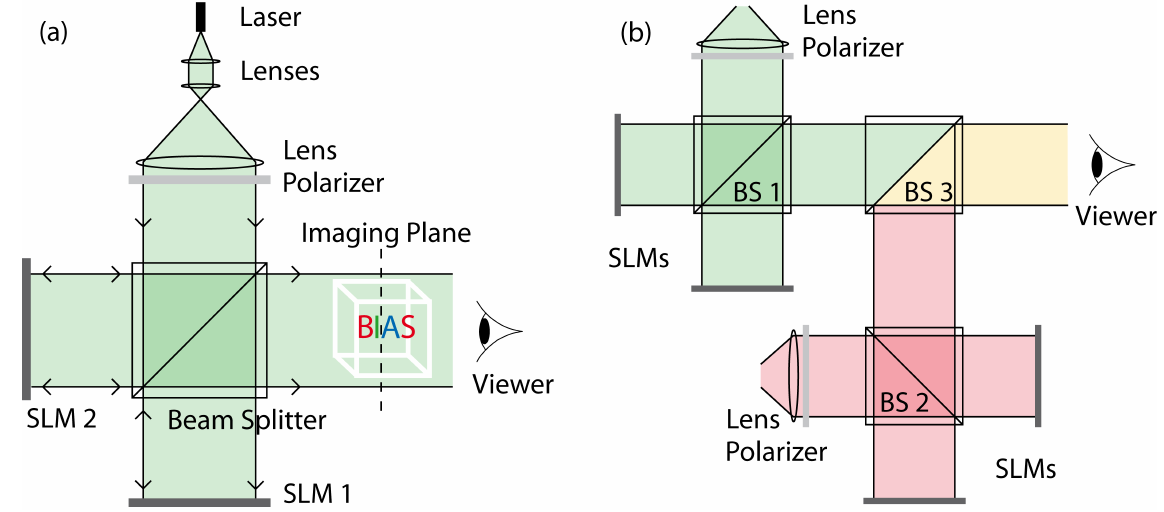
Figure 1. ( a ) Schematic representation of the Michelson-based RELPH setup. Light from a laser is expanded, parallelized, and linearly polarized in accordance with the birefringent axis of two phase-only liquid crystal spatial light modulators (SLM), placed after a beam-splitter, in the two interferometer arms of a Michelson setup. The reflected light is modulated by the SLMs to produce wave fields representing arbitrary 3D scenes in imaging planes laying anywhere in front of or behind the SLM plane; ( b ) Representation of the setup combination used for spatial multiplexing of several wavelengths. For simplicity, only a two-wavelength mixing is shown here. The light of two different wavelengths (shown in green and red, respectively) is modulated by two RELPH setups, identical to the one in ( a ). The modulated wave fields are superpositioned using the additional beam-splitter BS 3 for a multicolor viewing